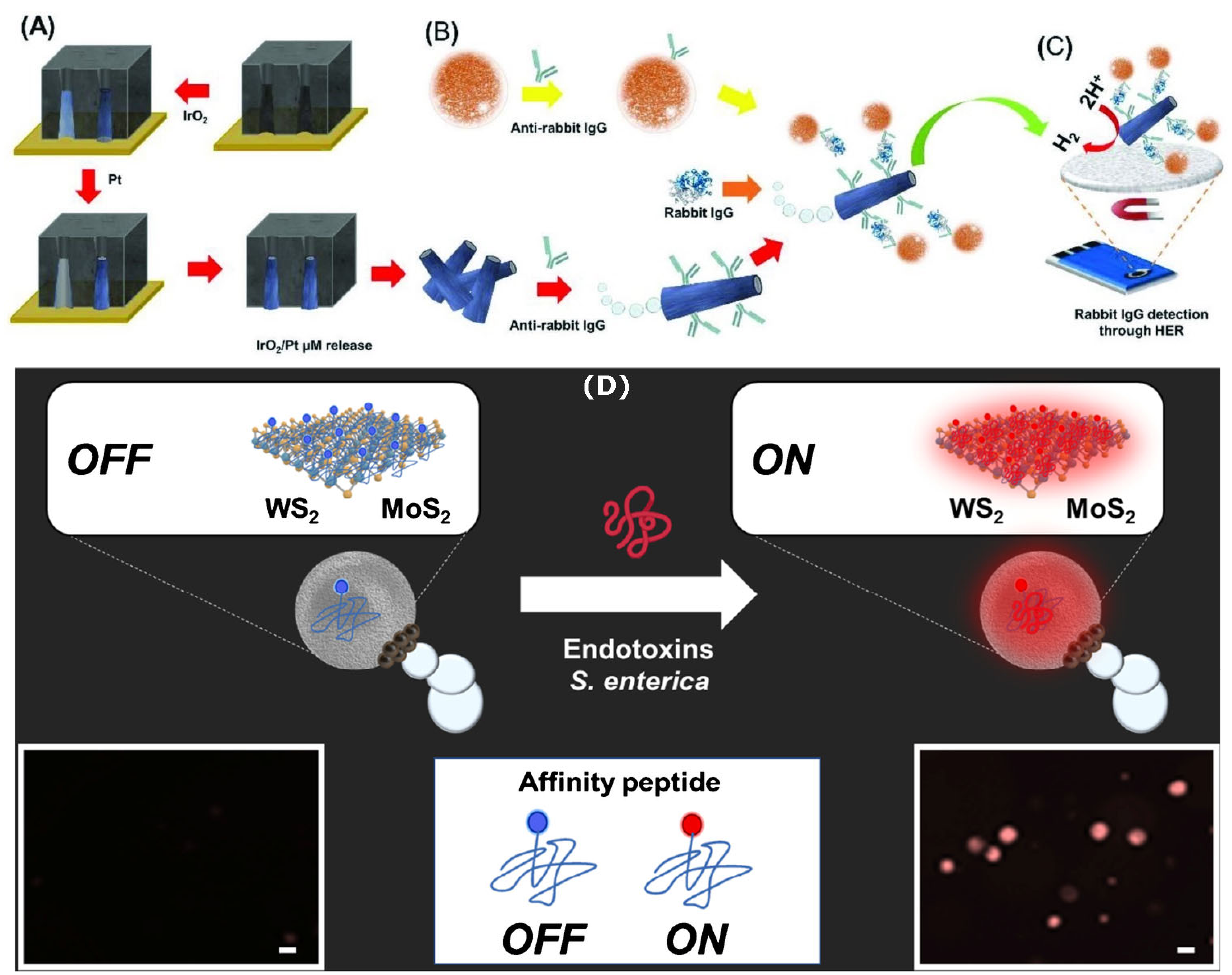
Figure 7. Schematic representation of the procedure to build IrO 2 on Pt microtube catalytic micro-motors ( A ), the formation of antibody–antigen–antibody complexes on the surface of the catalytic micromotors ( B ), the electrochemical quantification of the analyte concentration via the hydrogen evolution reaction ( C ), and the detection of bacteria endotoxin with catalytic micromotors which change fluorescence in the presence of the bacteria endotoxin ( D ); (Obs.: The targeted analyte is not involved in the catalytic process facilitating self-propulsion. However, self-propulsion is enhancing the probability of the catalytic micromotors to bind analyte molecules found in the sample.) Figures reproduced with permission from Ref. [68] (panels ( A – C )) and Ref. [69] (panel ( D )).